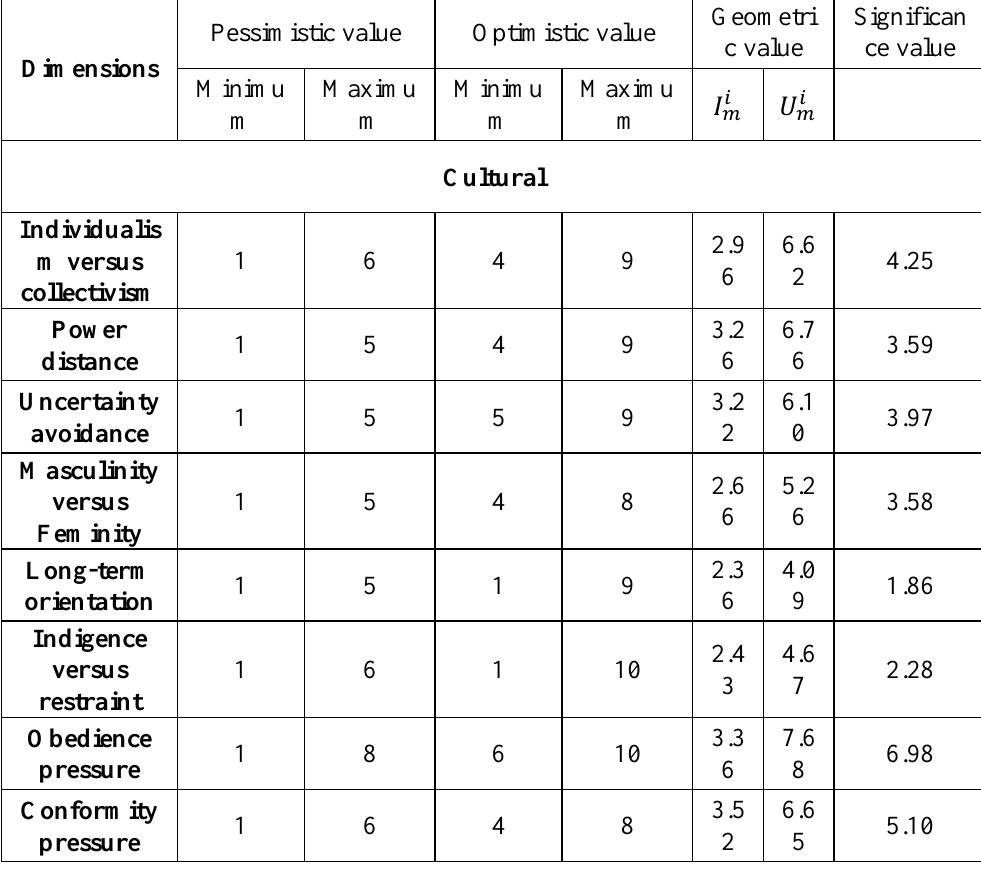
Table 3. Performance indicators based on the Fuzzy Delphi method Pessimistic value Optimistic Dimensions